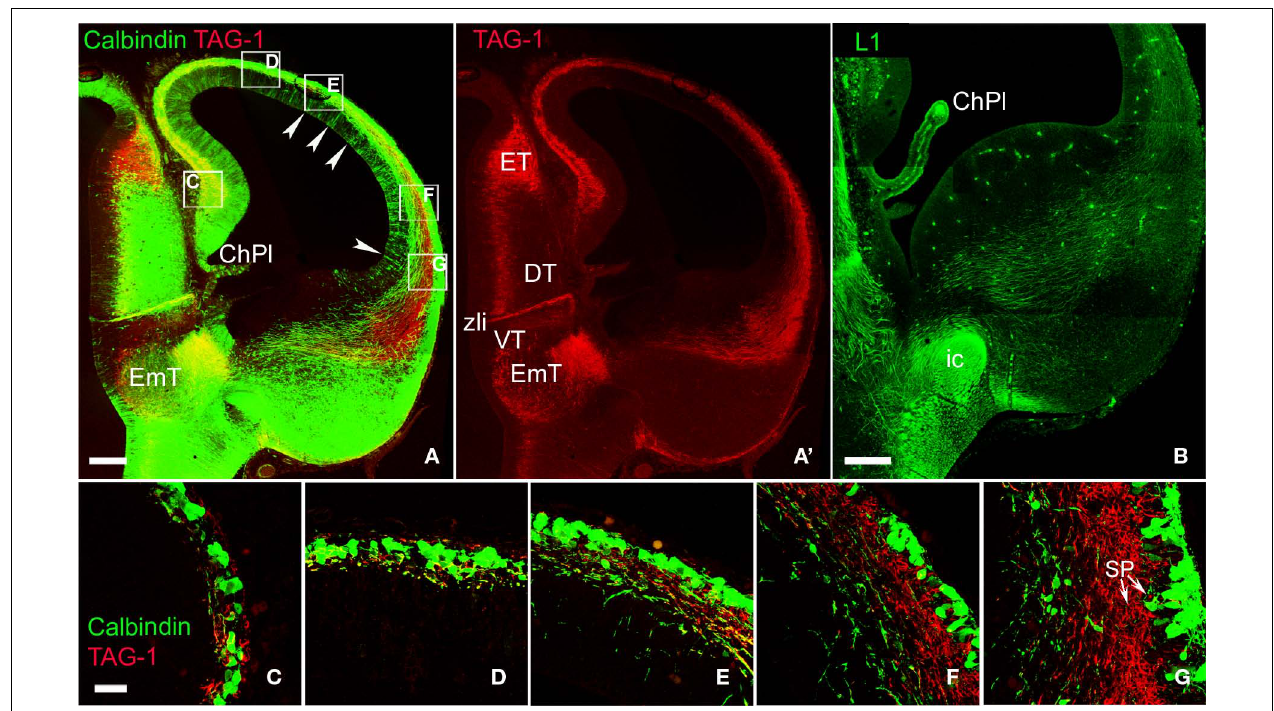
FIGURE 5 | Comparison of the axonal projections of CB + and TAG-1 + neurons in rats. (A) Shows a fl uorescence overlay of both markers and (A ′ ) shows TAG-1 immunoreactivity separately. Note that the territory of distribution of TAG-1 + axons overlaps only partially with that of CB + axons. Arrowheads in (A) point to CB + cells in the ventricular zone. (B) Distribution of L1 + corticofugal axons avoiding the posterior limb of the internal capsule. (C–G) show high magnifi cation fl uorescence overlays of the boxed areas in (A) . Note the lateral-to-medial